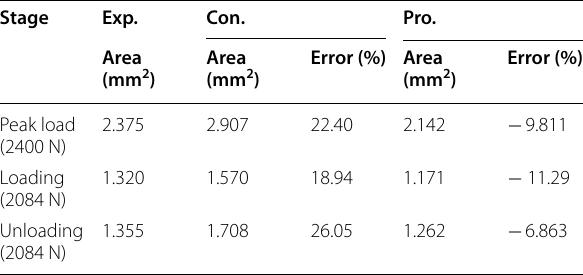
Table 8 Area of crack tip plastic zone obtained by using different methods and corresponding error Stage Exp.